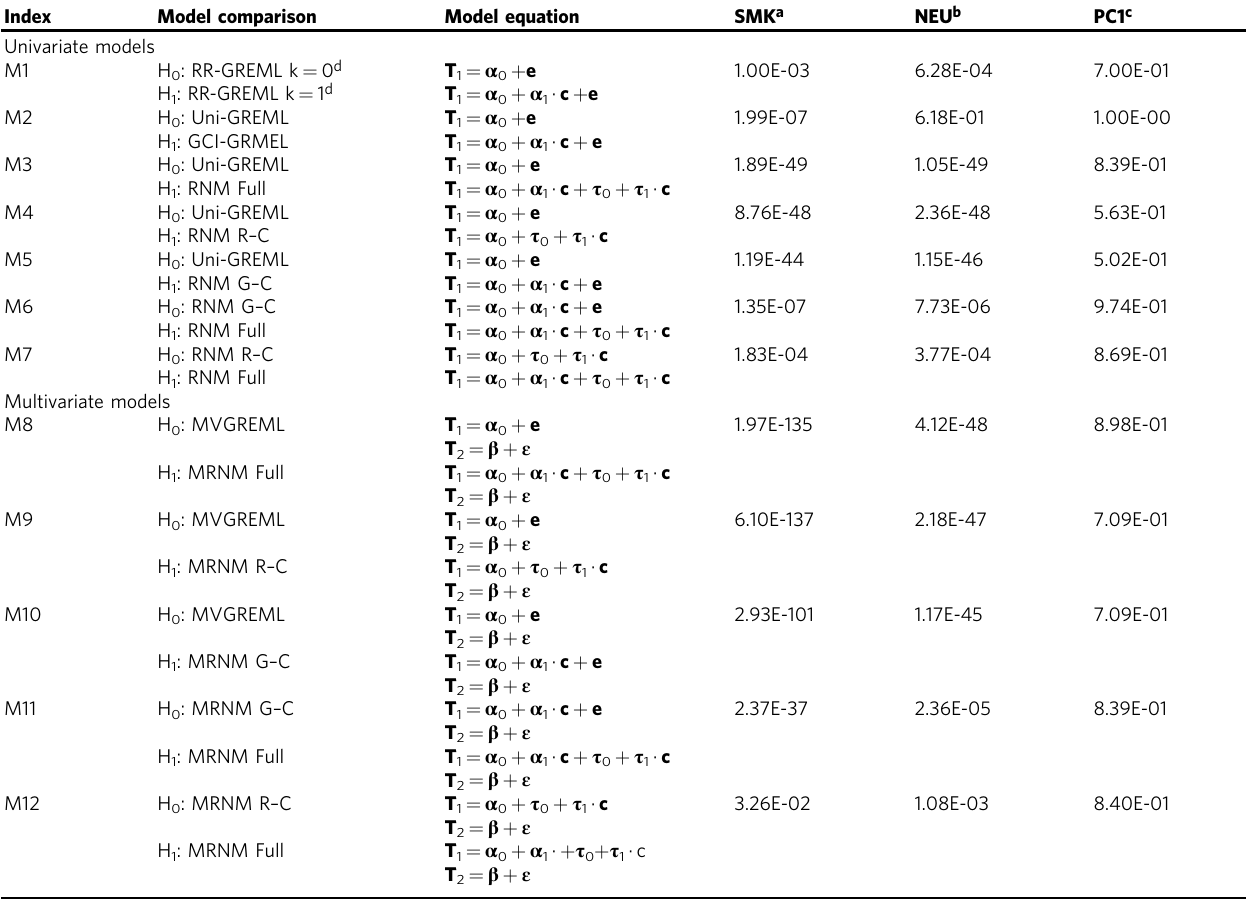
Table 1 P -values of likelihood ratio tests for model comparisons in UK Biobank analyses of BMI Index Model comparison Model equation Univariate models